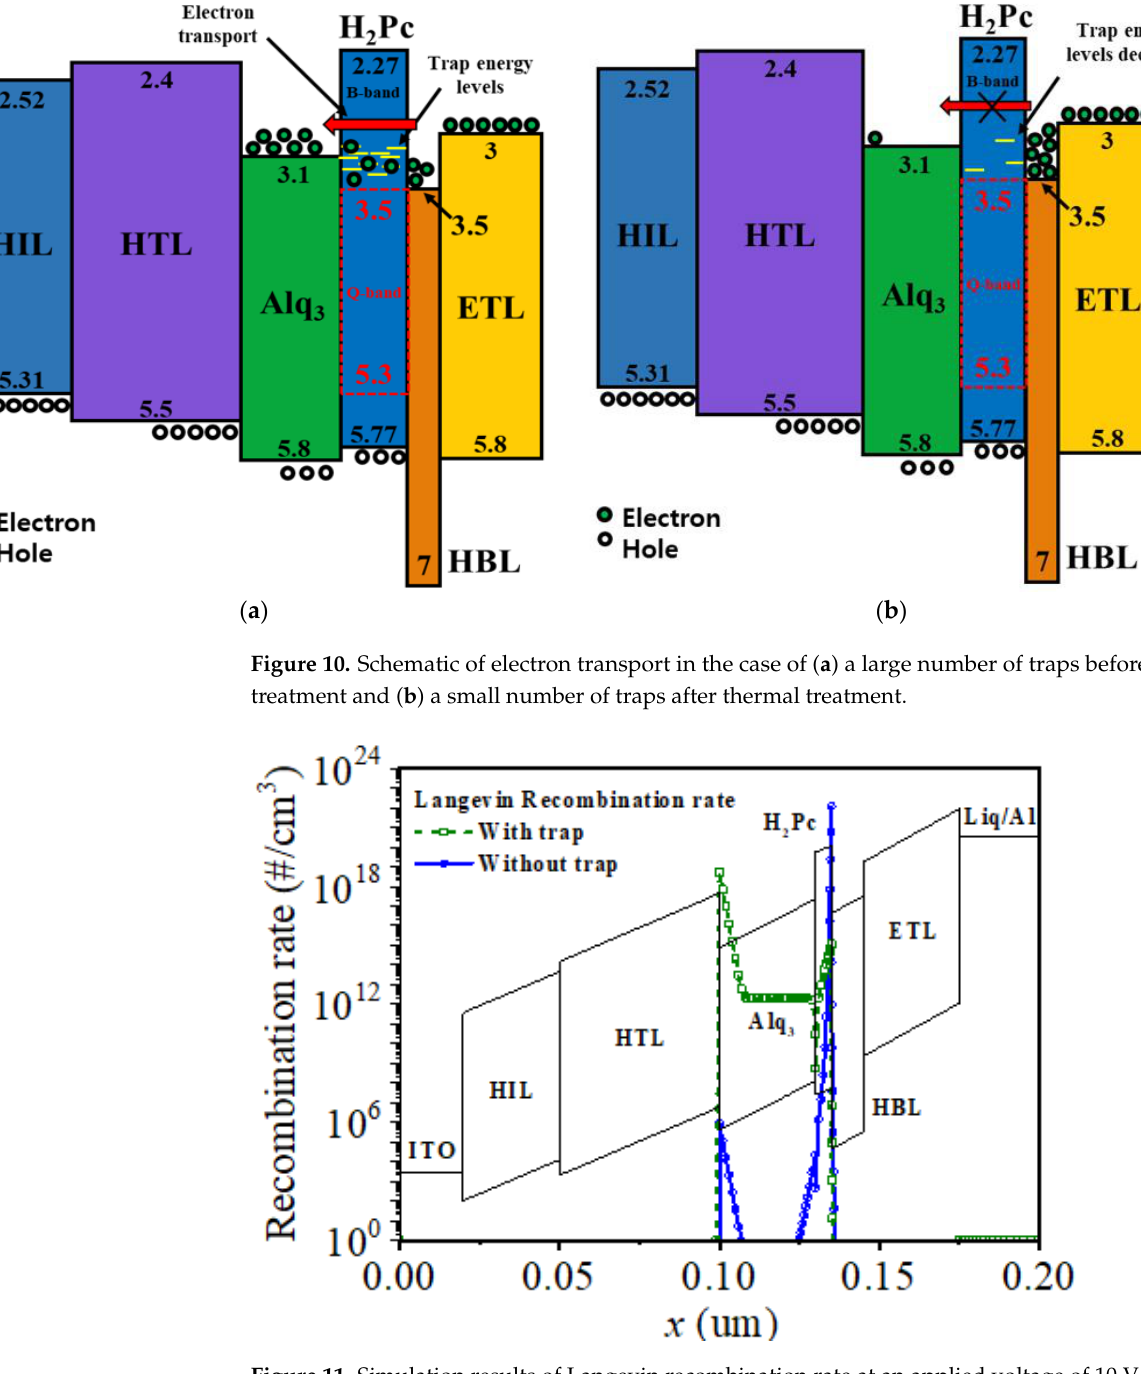
Figure 11. Simulation results of Langevin recombination rate at an applied voltage of 10 V with and without trap using technology computer-aided design (TCAD).